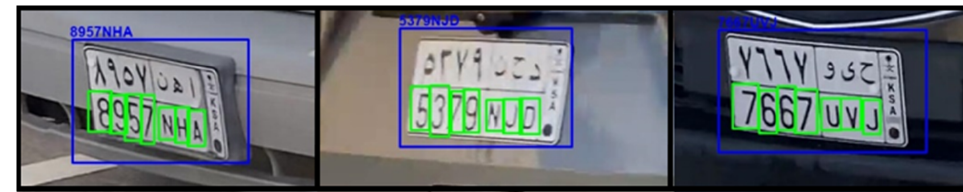
Figure 18. Obliqued LPs and respective recognition results.